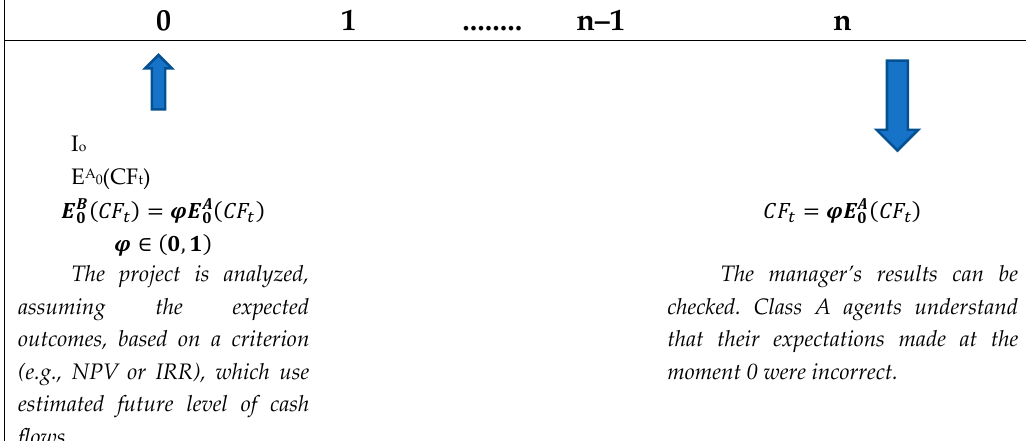
Figure 1. The long period between the decision-making process and the control of its result.